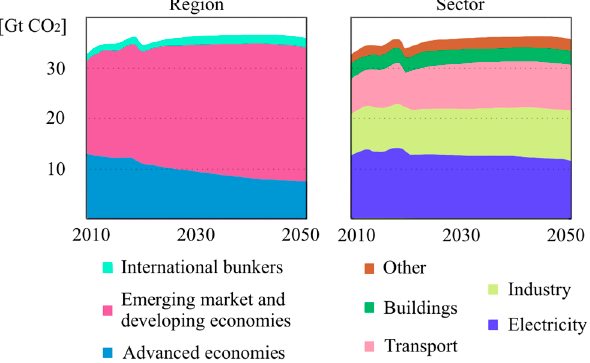
Figure 4. Energy-related and industrial process CO 2 emissions by region and sector [2].